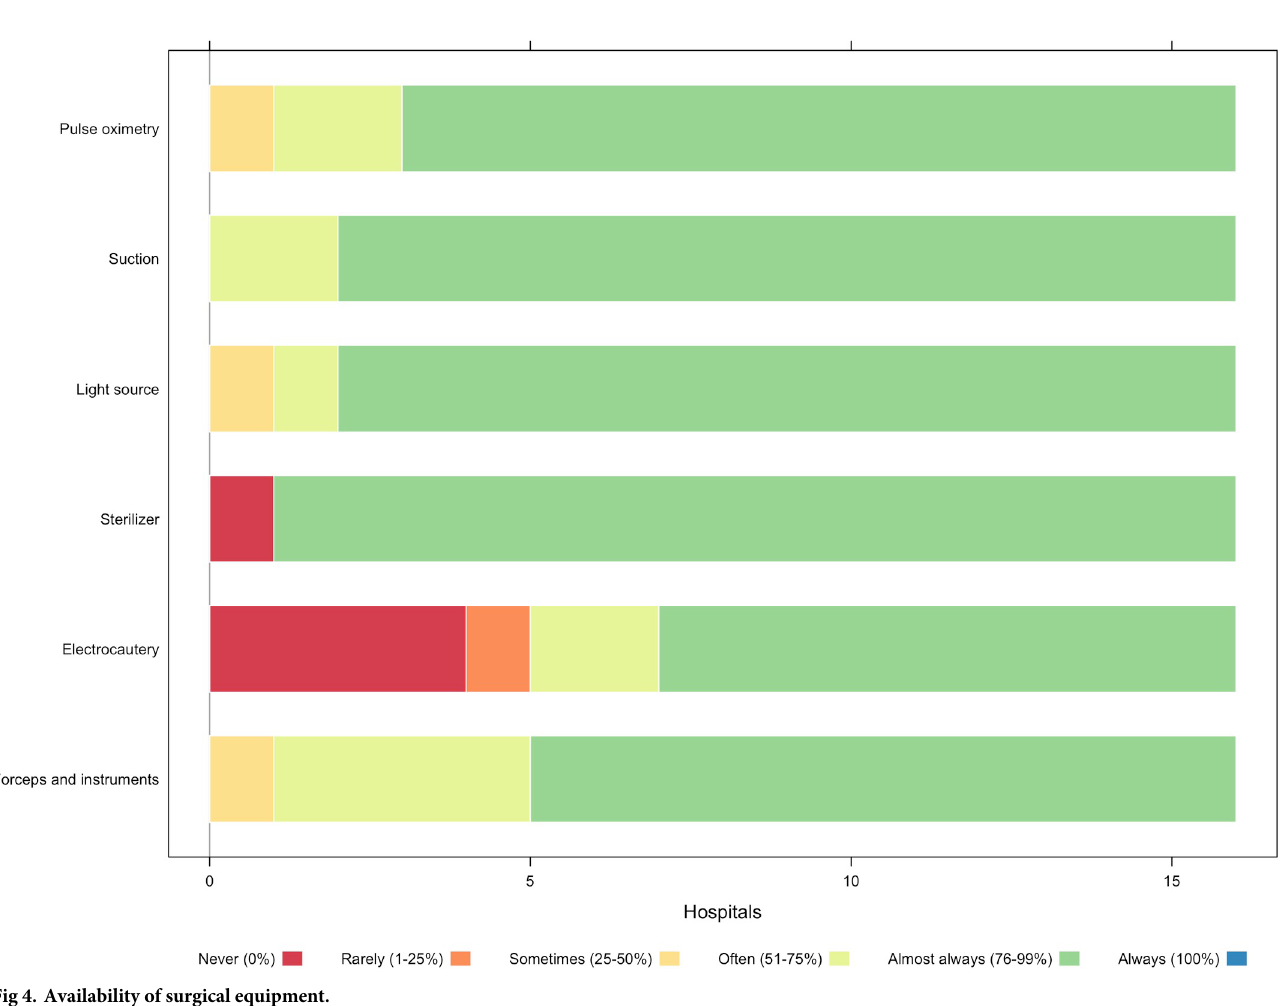
Fig 4. Availability of surgical